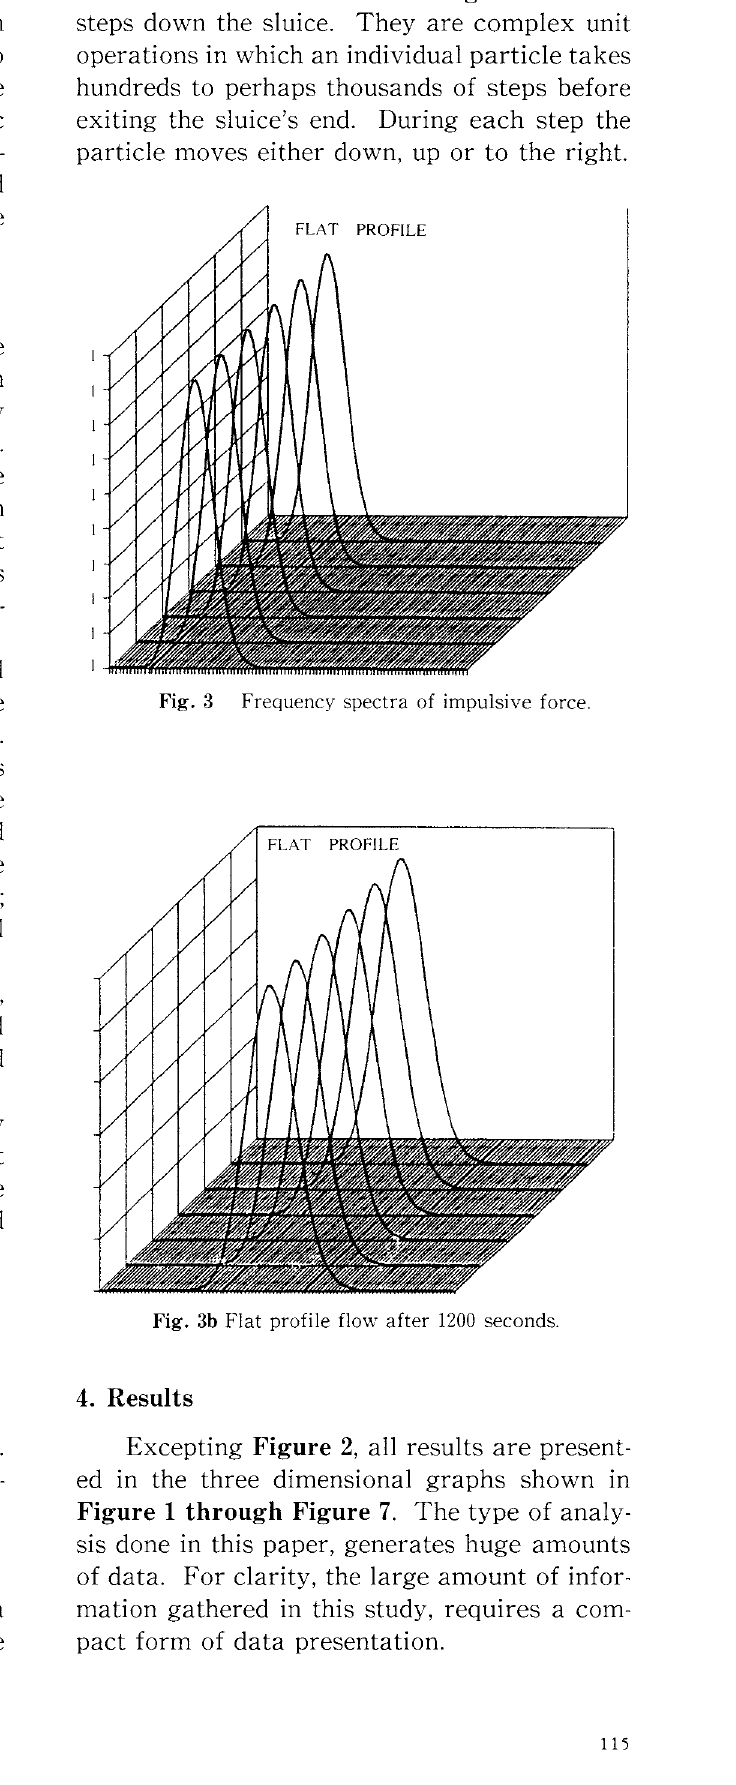
Fig. 3b Fiat profile flow after 1200